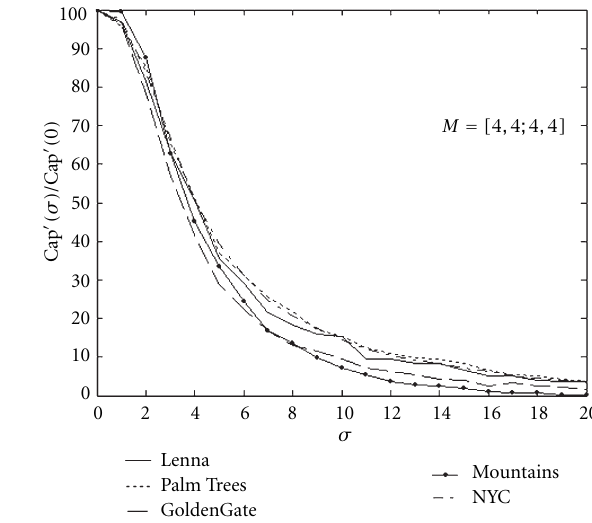
Figure 5: Capacity versus noise amplitude σ